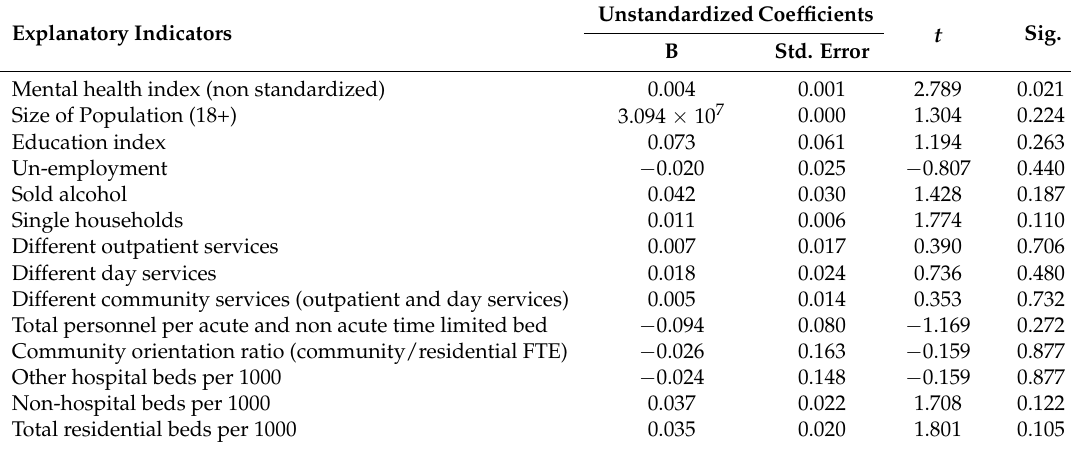
Table 5. Linear regression models explaining use of acute and semi-acute beds with explanatory indicators. (one by one) standardized by mental health index *